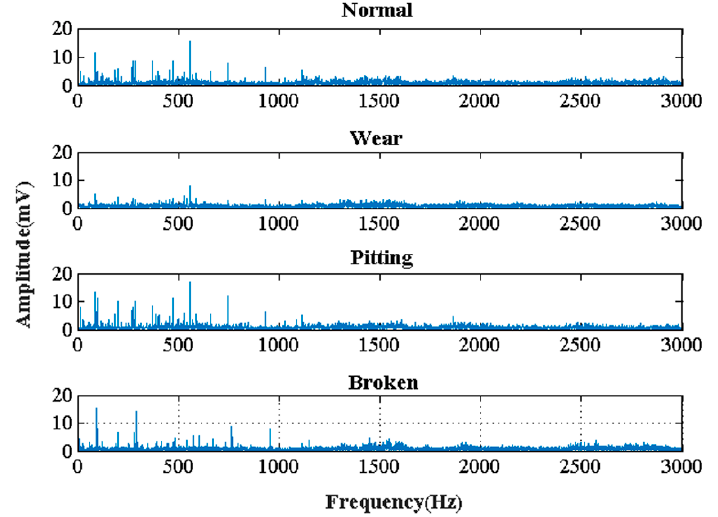
Figure 8. Frequency − domain diagram of four types of the gearbox vibration data.